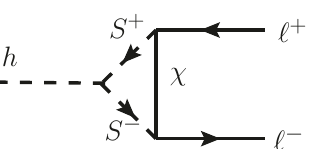
Figure 8 . The one-loop induced h‘ + ‘ − coupling modification.